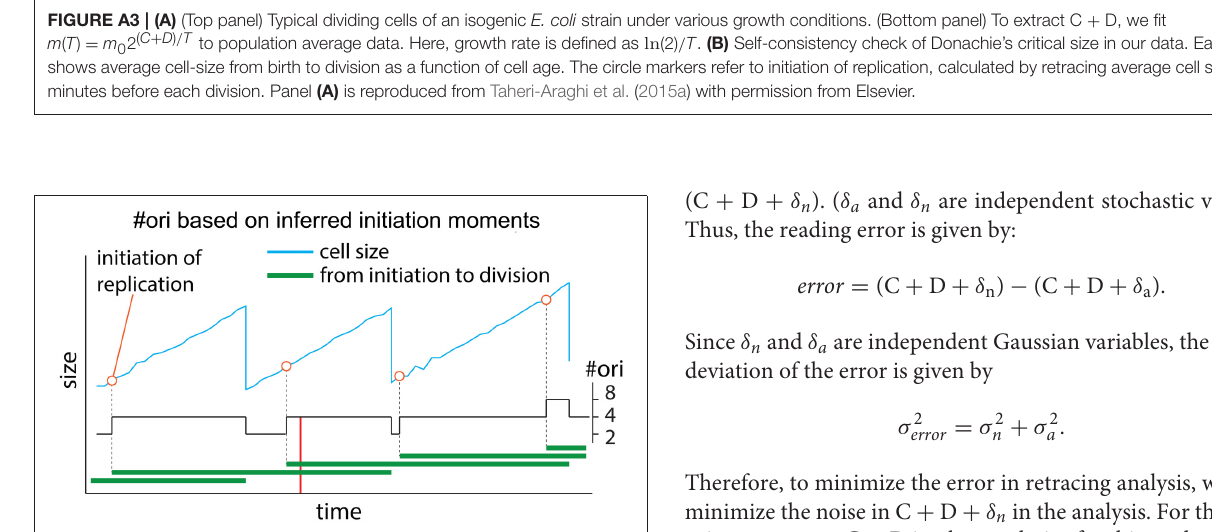
FIGURE A4 | Number of origins of replication, # ori , based on inferred initiation moments. If N replication cycles overlap at any time point (green horizontal lines in the graph) during cell cycle, the total number of origins at that time point is # ori = 2 N